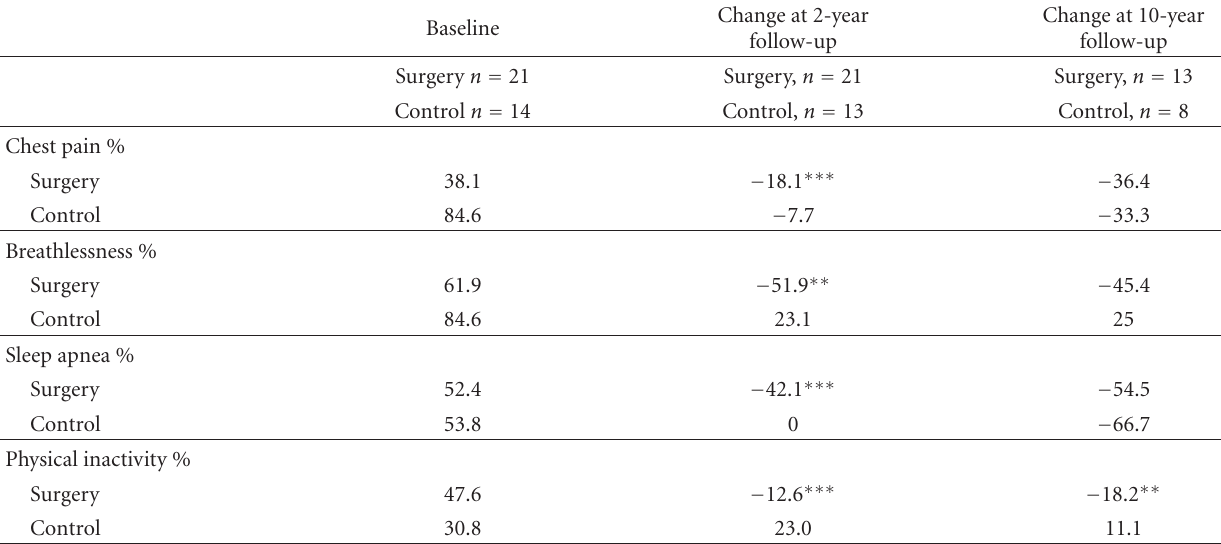
Table 2: Chest pain, breathlessness sleep apnea, and physical activity (%) in the surgery and control groups at baseline and changes in prevalence after 2 and 10 years of follow-up. Only the patients applicable for the certain timepoint are included in the statistical calculations.